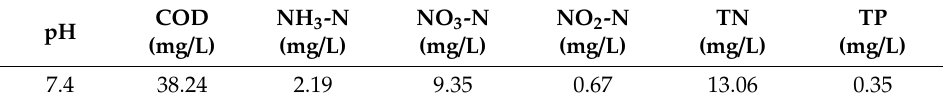
Table 1. Water quality index of tail water from Nanjing JX Sewage Treatment